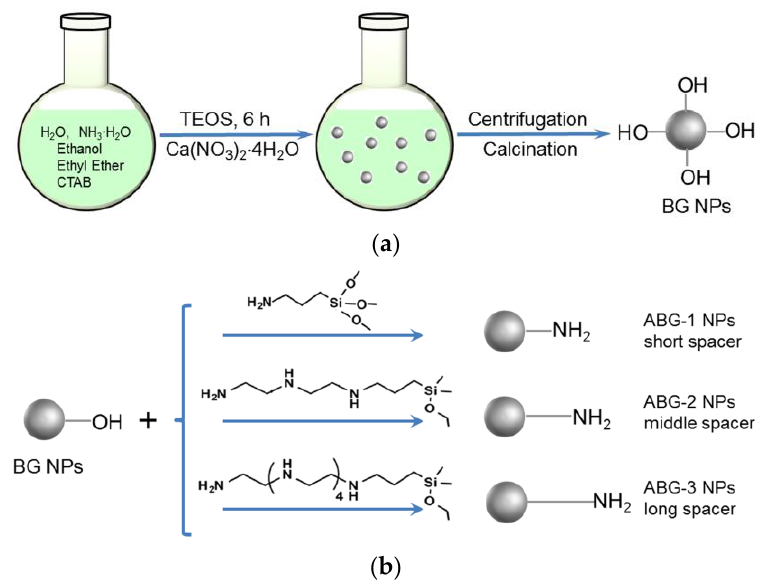
Figure 1. Scheme for synthesis of BG NPs ( a ) and different kinds of ABG NPs ( b ) with varied spacer lengths.